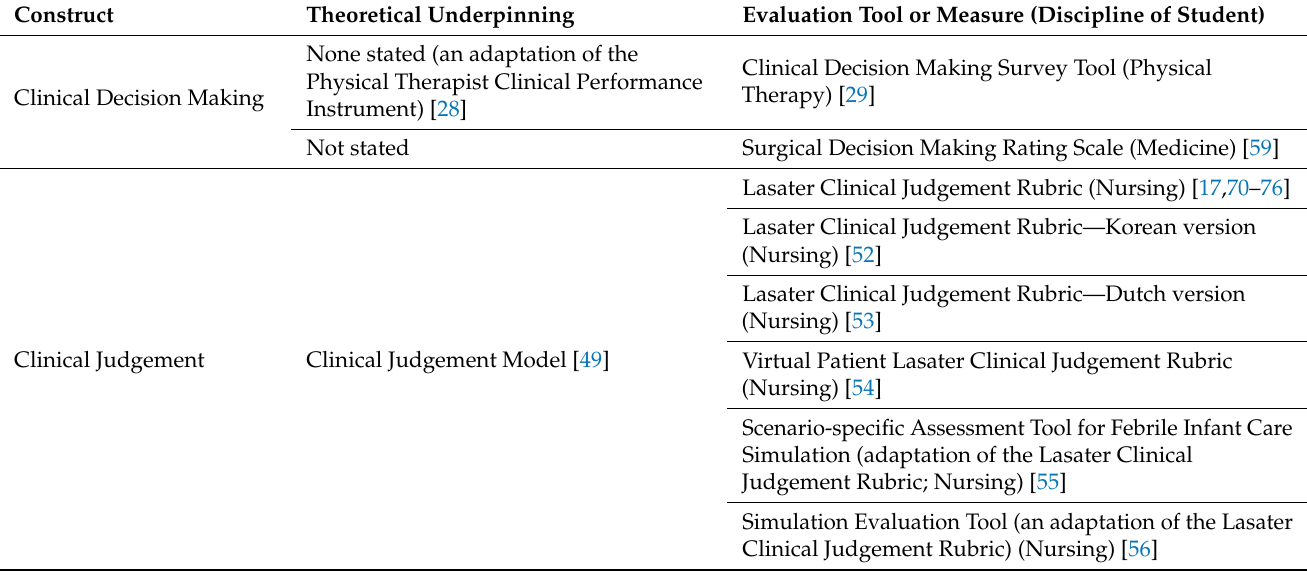
Table 2. Constructs measured in evaluations of students’ clinical